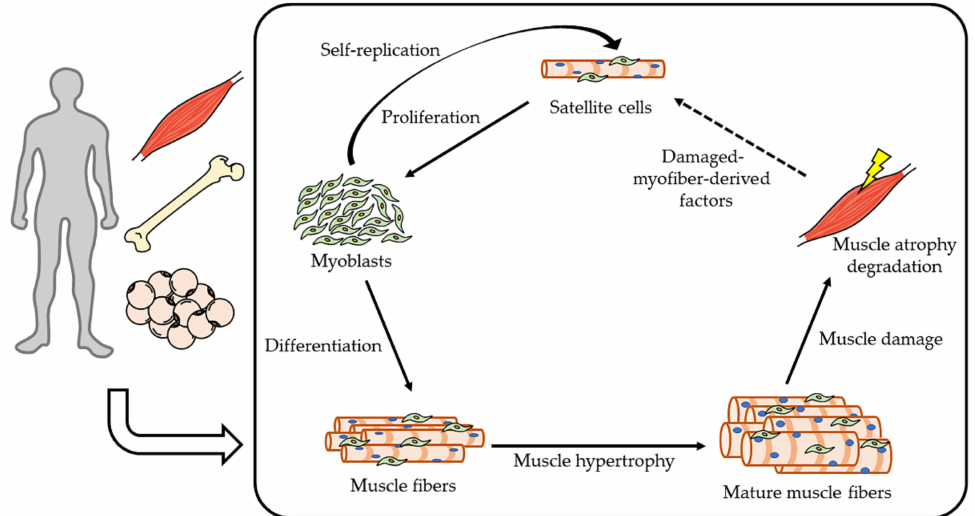
Figure 2. Muscle remodeling